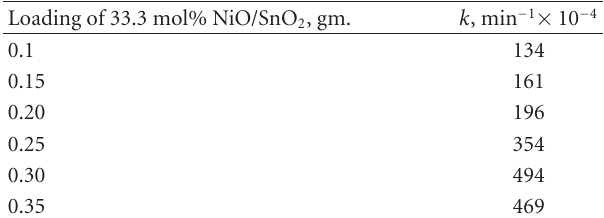
Table 4: Apparent rate constant ( k ) at di ff erent loading of 33.3 mol% NiO/SnO 2 . Loading of 33.3 mol% NiO/SnO 2 ,